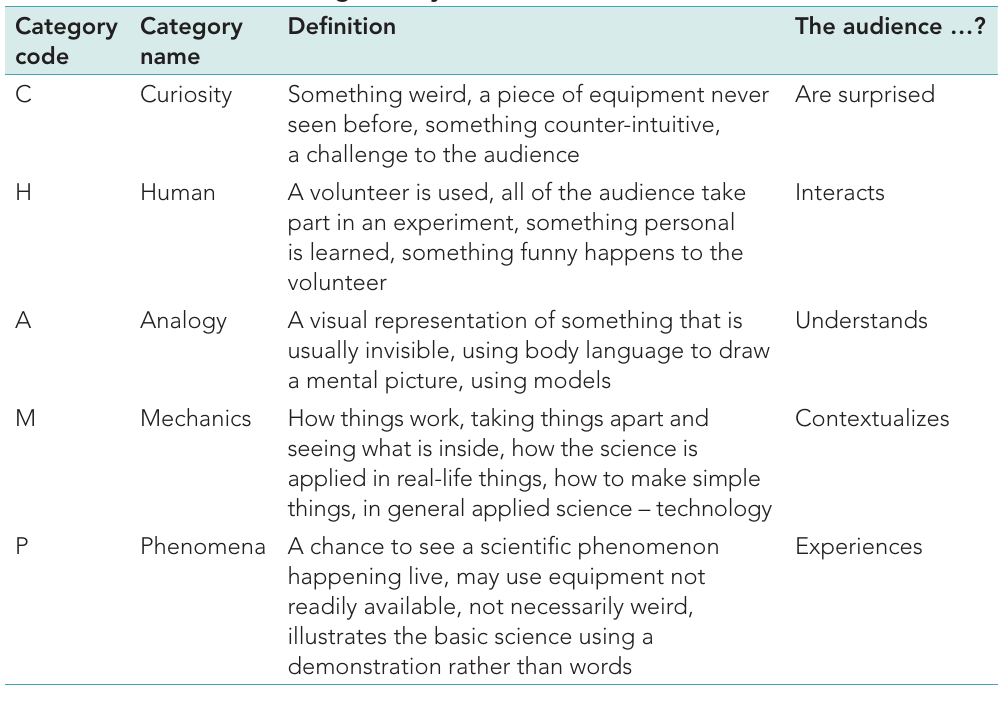
Table 2: Demonstration categories by characteristic